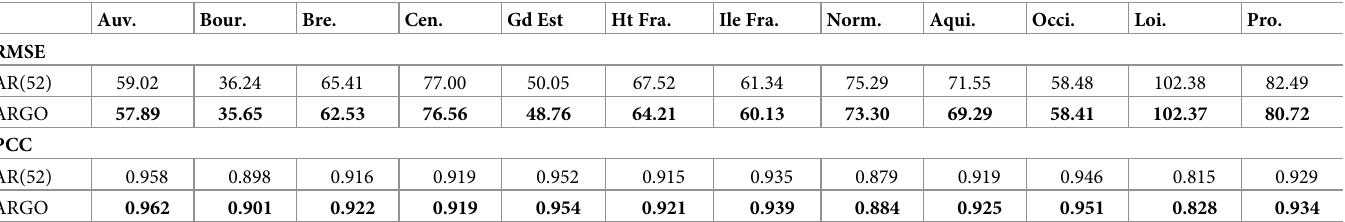
Table 3. Two-week ahead estimate—RMSE and PCC for ARGO models including only historical data (AR(52)) and the ten most correlated variables from hospital and Google data, for the period starting from January 2015 to March 2017. Auv. Bour. Bre. Cen. Gd Est Ht Fra. Ile Fra. Norm. Aqui. Occi. Loi. Pro. RMSE AR(52) 144.22 147.70 PCC AR(52)